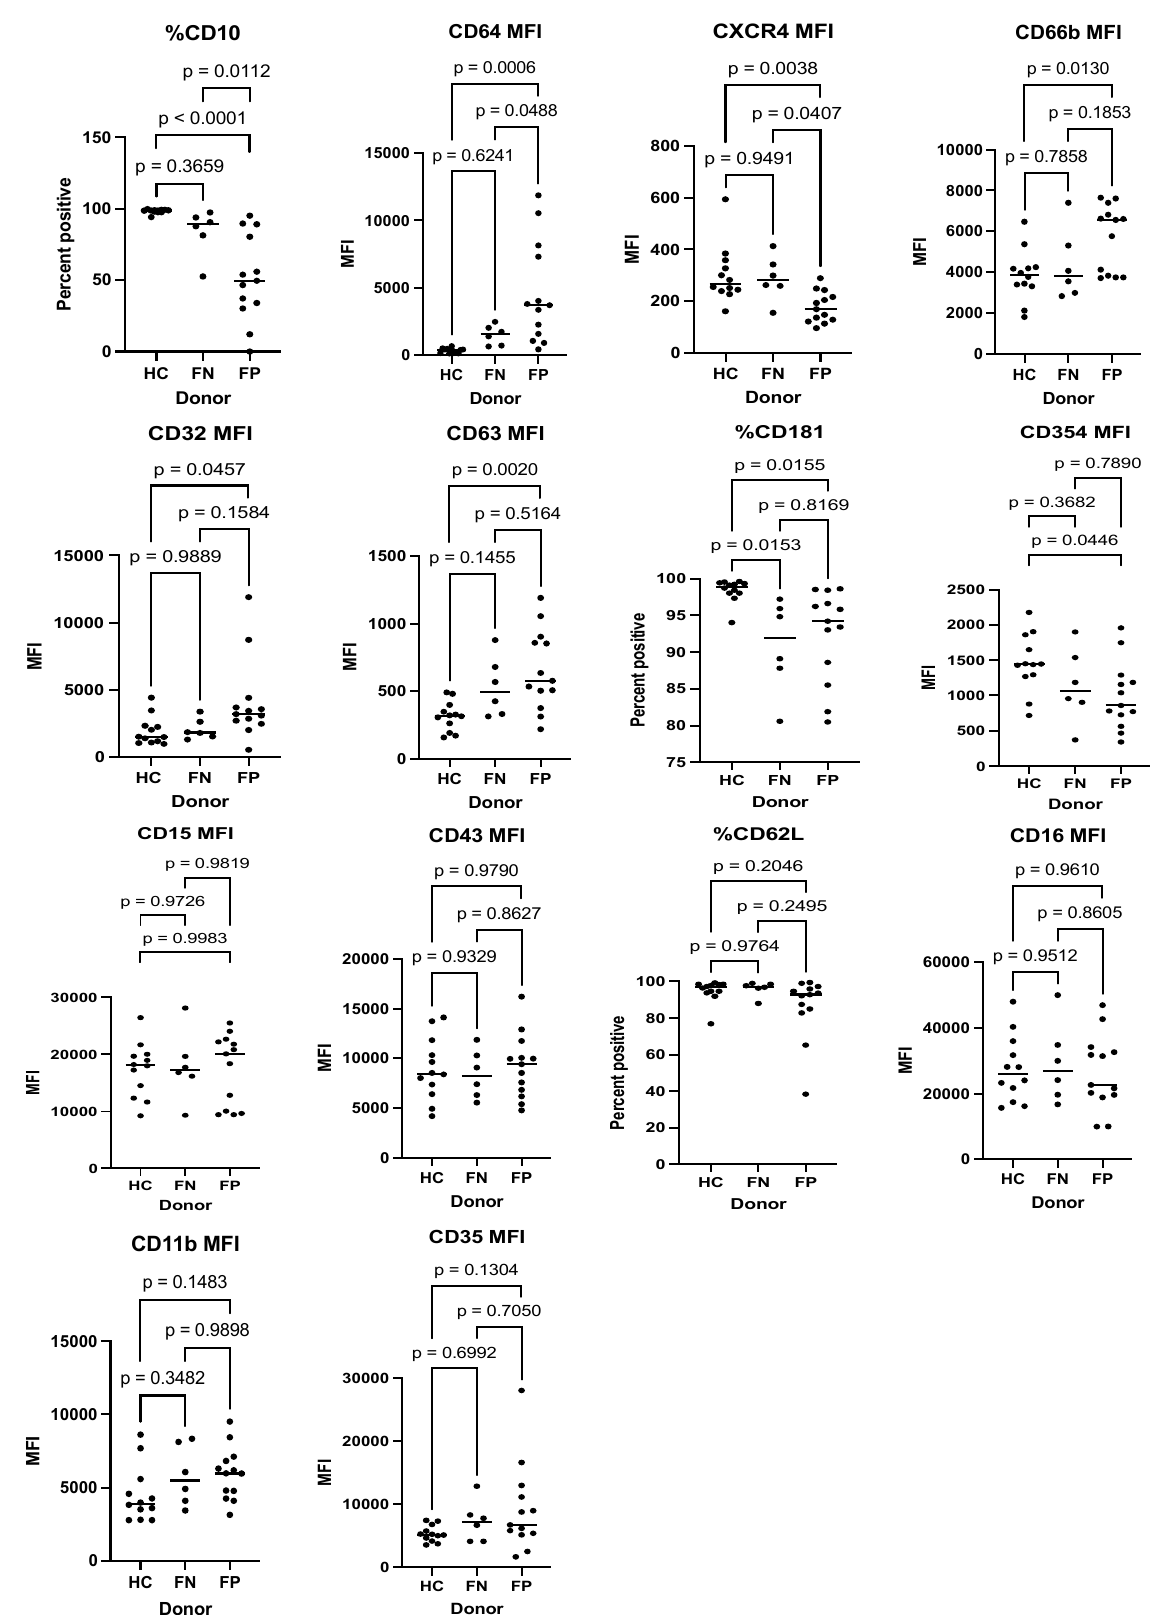
Figure 7. Distribution of surface markers using flow cytometry for FP, FN, and HC group